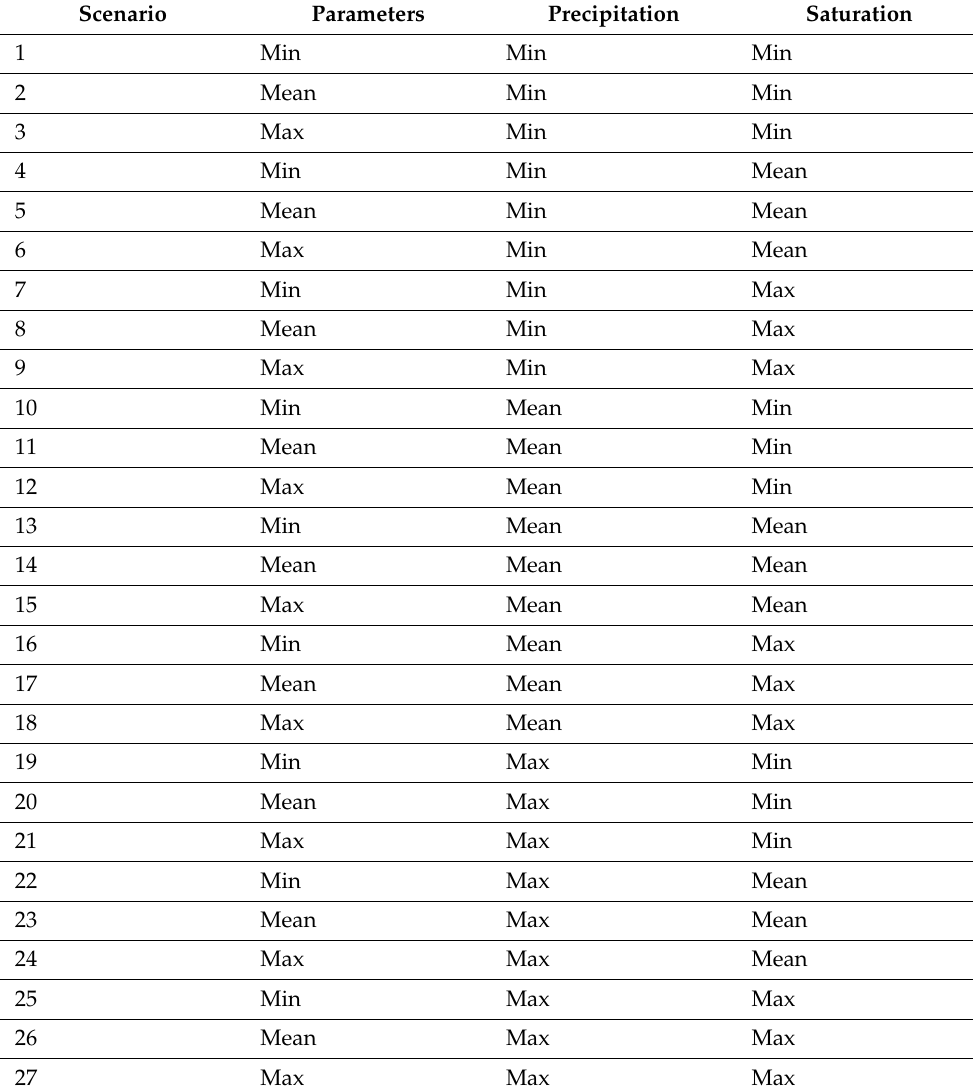
Table 4. Scenarios for batch